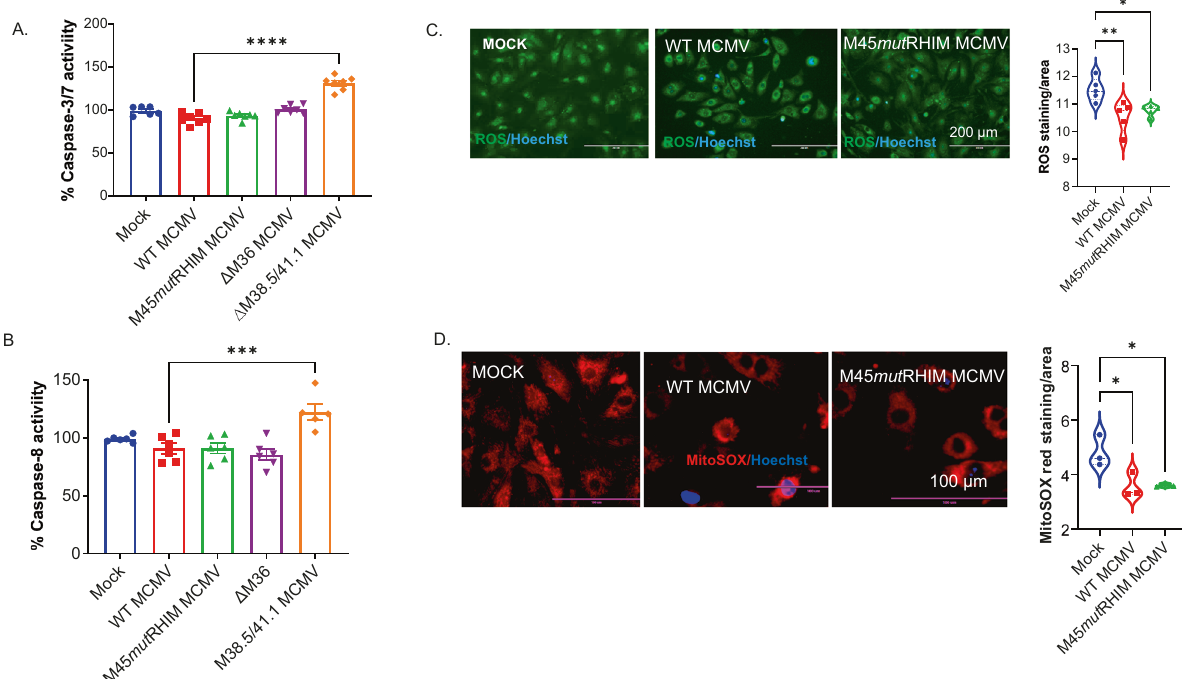
Fig. 2 MCMV infection prevents apoptosis in cardiomyocytes by reducing ROS. A – B . Caspase-3/7 and caspase-8 activity in uninfected (MOCK), and WT, M45 mut RHIM, Δ M36, and Δ M38.5/41.1 MCMV infected neonatal cardiomyocytes. C Staining of cellular oxidative stress (ROS) by CellROX and its quanti fi cation in neonatal cardiomyocytes infected with WT MCMV and M45 mut RHIM MCMV. D Staining of mitochondrial ROS by MitoSOX and its quanti fi cation ( n = 3 samples in each group). WT CMV = K-181-bac, Δ M36 = mutant CMV mutant promotes caspase-8- mediated apoptosis, Δ M38.5/41.1 CMV = mutant CMV promotes mitochondria-mediated (Bax/Bak) apoptosis. One-way ANOVA followed by Tukey ’ s multiple comparison test was performed. Values are mean ± SE. Each point represents one sample. n = 5 – 6 in ( A – B ) and n = 3 in ( C – D ). * P < 0.05; ** P < 0.01; *** P < 0.001; **** P <